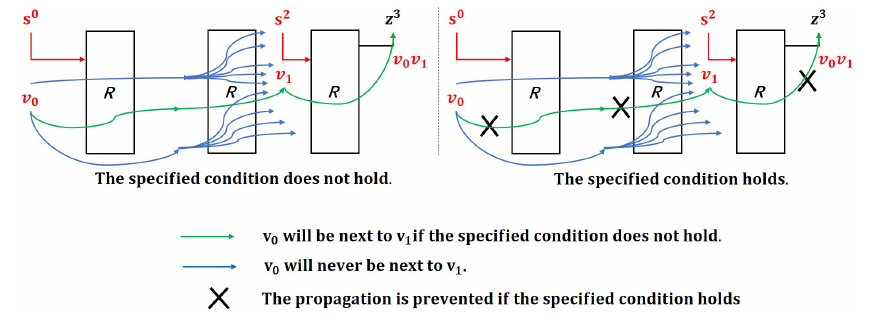
Figure 6: Illustration of TYPE-III conditional cube